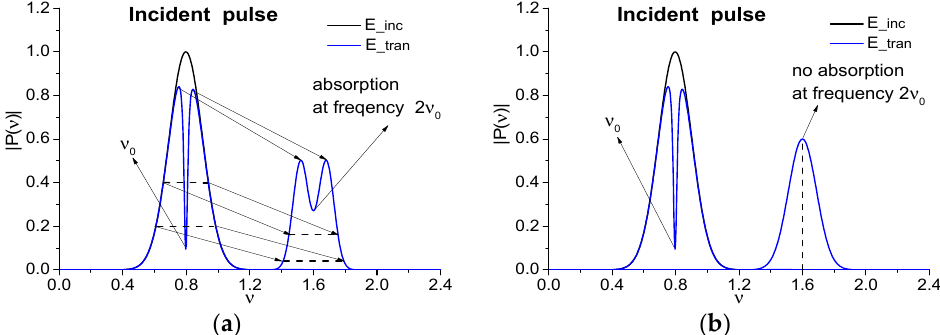
Figure 1. Scheme of verification of the substance absorption frequencies. The absorption frequencies ν 0 , 2 ν 0 occurring in the spectrum of the incident broadband pulse, transmitted through a substance, are seen in the spectrum of the incident narrowband signal (E_tran), transmitted through this substance, at changing its carrier frequency ( a ). Thus, the frequency 2 ν 0 is a true absorption frequency. ( b ) demonstrates that the frequency 2 ν 0 is induced by the up-conversion process (the spurious frequency), because it is not observed in the spectrum of the incident narrowband signal transmitted through a substance. Black line denotes the spectrum of the incident narrowband signal (E_inc).